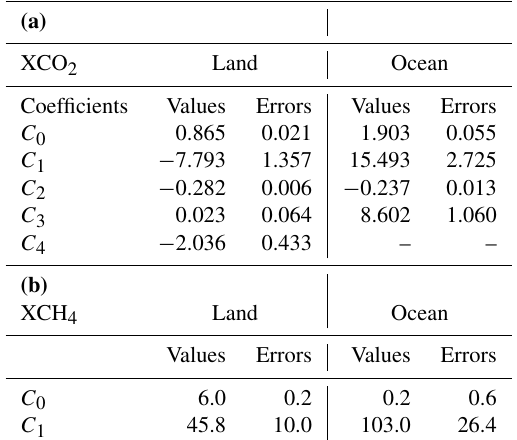
Table 3. Values and errors of the regression coefficients for (a) XCO 2 and (b) XCH 4 retrievals calculated by multiple linear re- gression. The units of C 0 , C 1 , C 2 , C 3 , and C 4 for XCO 2 are (ppm), (ppm/units of AOD), (ppm/hPa), (ppm/airmass), and (ppm/units of albedo), respectively. The units of C 0 and C 1 for XCH 4 are (ppb) and (ppb/units of AOD),